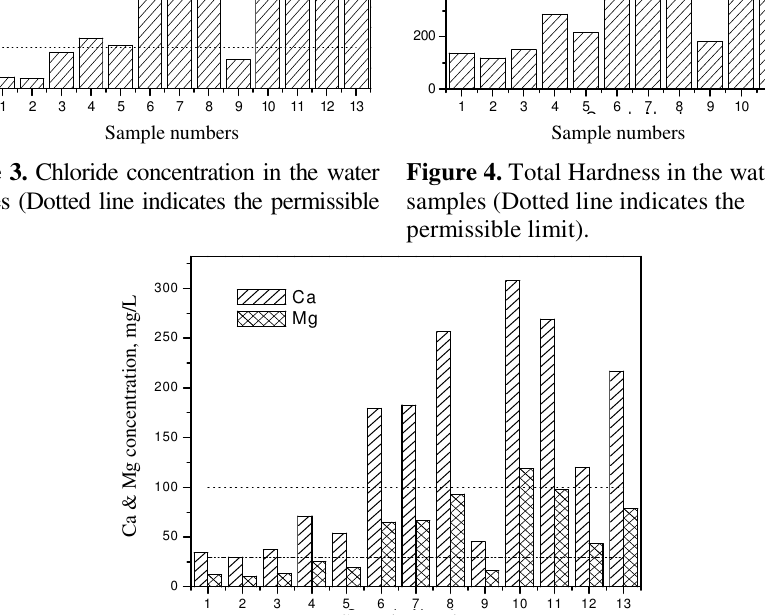
Figure 5. Ca & Mg concentration in the water samples (Dotted line indicates the permissible